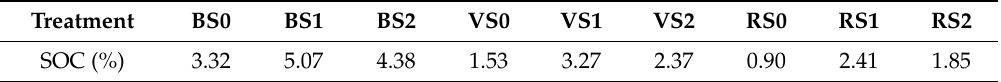
Table 1. Soil organic carbon (SOC), as affected by biochar (BC) application after one-year of aging. BS, black soil. VS, Vegetable garden soil. RS, red soil. Treatment